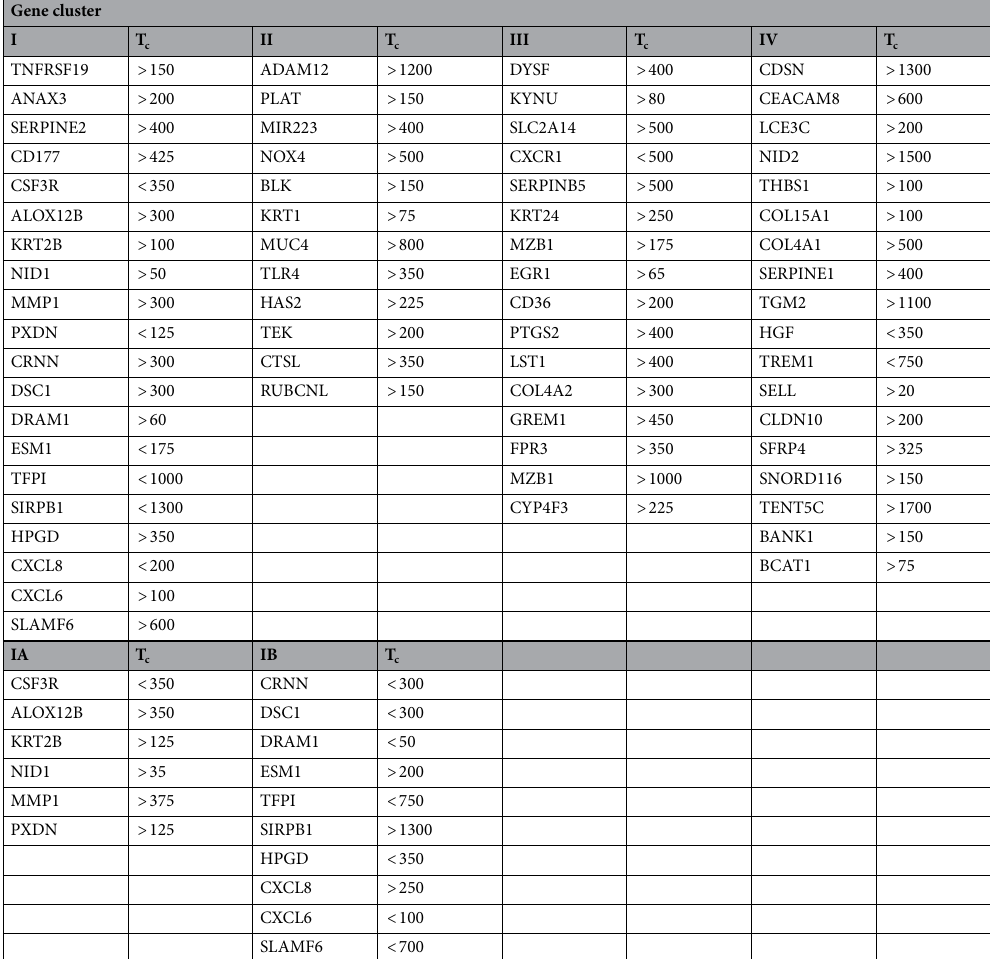
Table 4. Gene clusters used to categorize the gingival samples. The threshold cutoff ratio determined as T c for the normalized